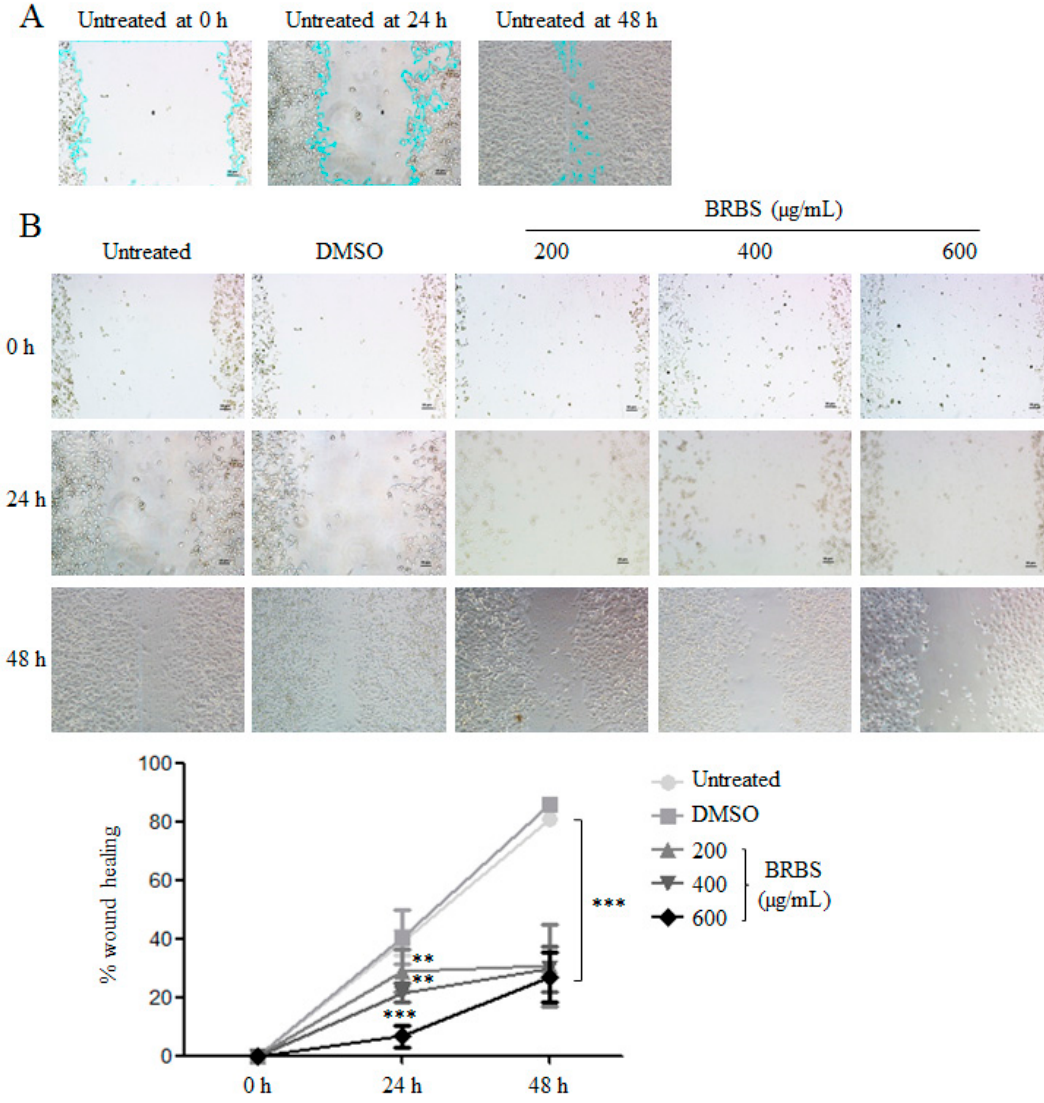
Figure 6. BRBS inhibits A549 cell migration ( A ) The gating strategy of scratch area by Image J. ( B ) After BRBS treatment for 24 and 48 h, A549 cell migration was observed by inverted microscope and analyzed by Image J. ** p < 0.01; *** p < 0.001 compared to Untreated.